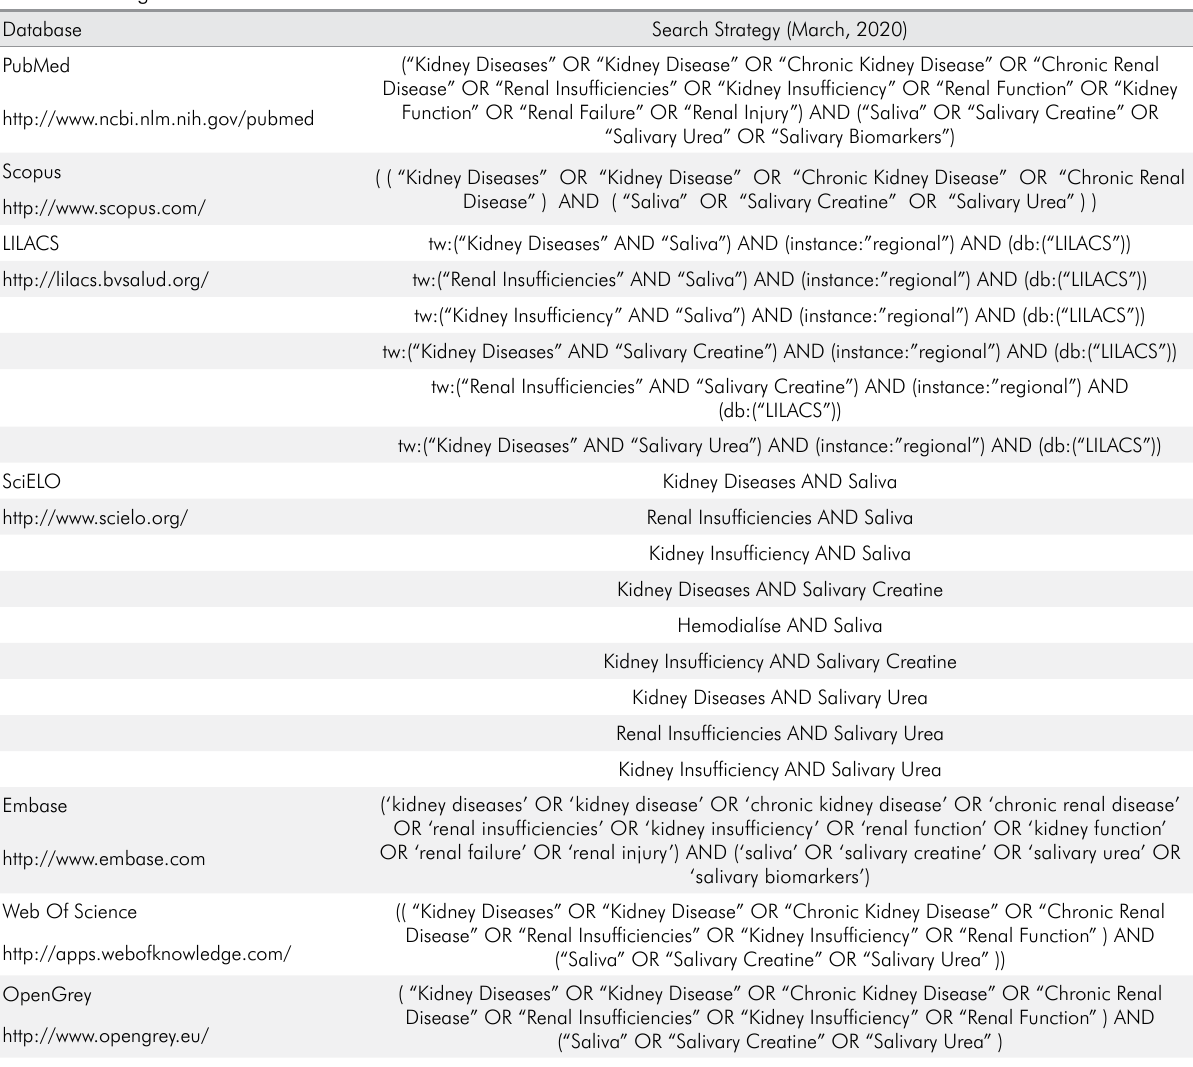
Table 1. Strategies for database